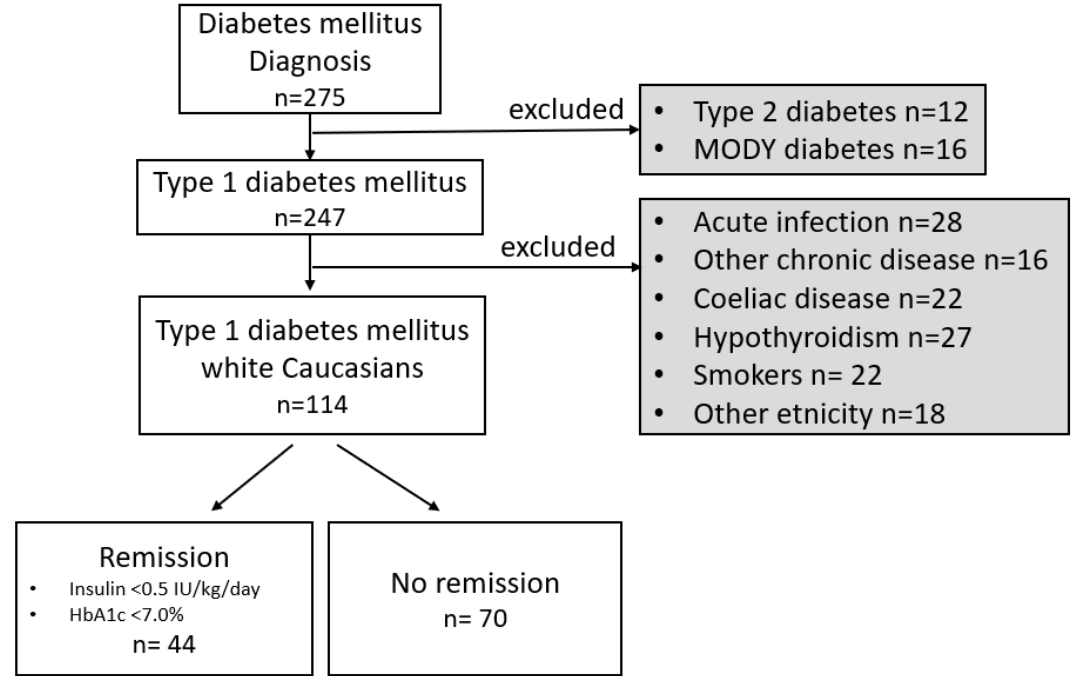
Figure 1. Flow chart documenting inclusion criteria, exclusion criteria, and the number of individuals included in the study population. Abbreviations : MODY—Maturity Onset Diabetes of the Young, IU—International Units, HbA1c—glycated hemoglobin A1c, remission was classified according to ISPAD guidelines 2018 as total daily dose of insulin < 0.5 IU/kg/day and HbA1c < 7.0% (53 mmol/mol).